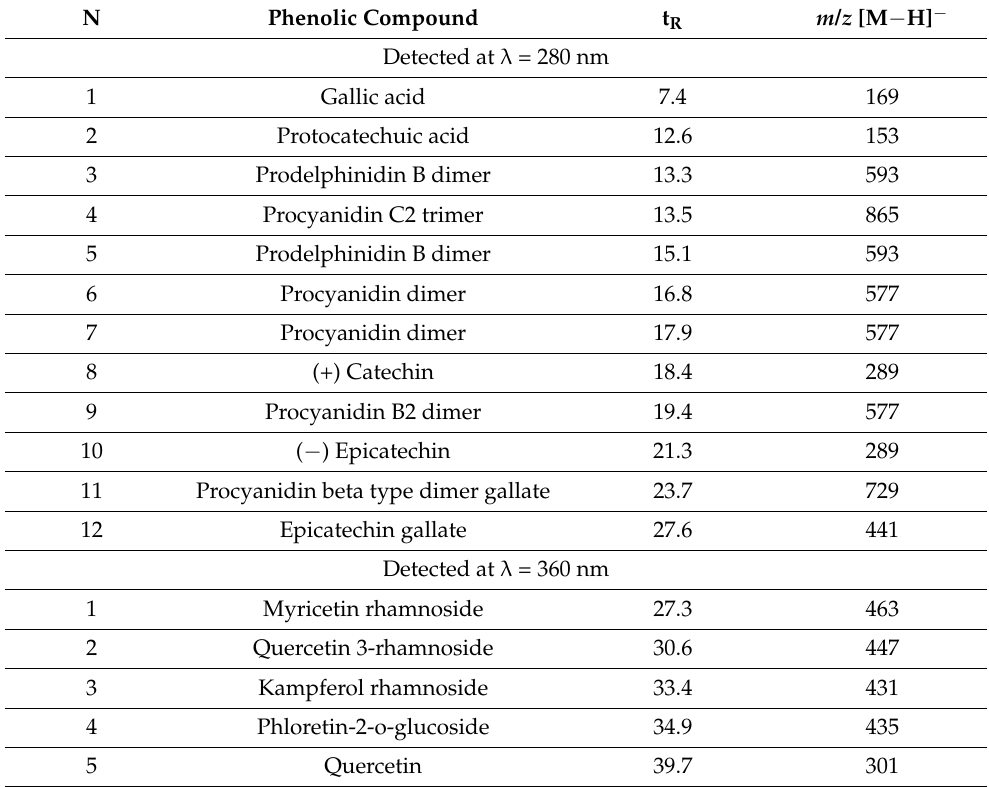
Table 1. HPLC-PDA/ESI-MS identification of phenolic compounds in hazelnut skin extract.